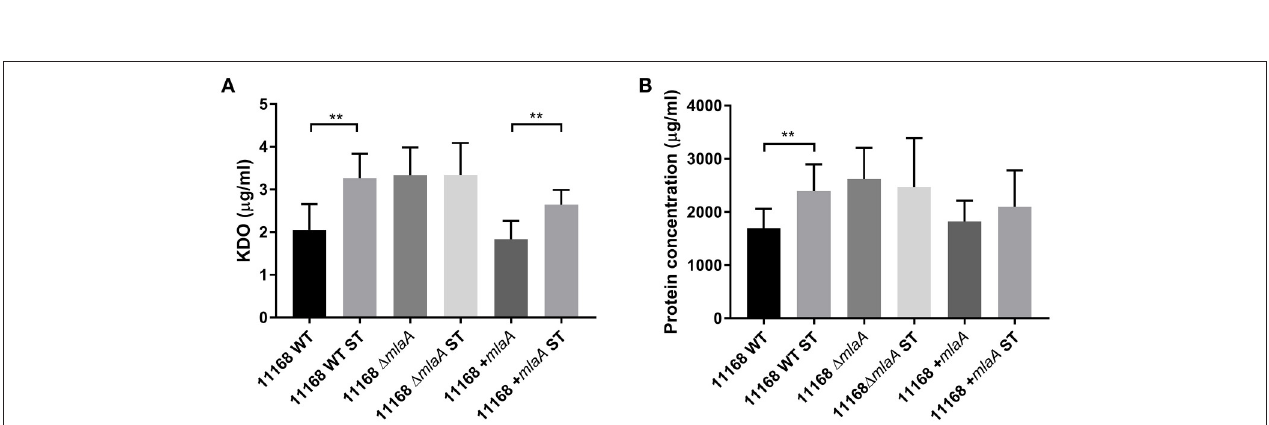
FIGURE 5 | The presence of a biologically relevant concentration of ST increases OMV production in C. jejuni wild-type strain but not in the mlaA mutant. OMVs were isolated from late-log phase C. jejuni cultures grown in Brucella broth either in the presence or absence of 0.2% (w/v) ST. OMV and ST-OMV preparations from cultures of C. jejuni wild-type, mlaA mutant and complement strains of equivalent OD 600 values were quantified by analyzing (A) total KDO as a measurement of LOS and (B) total protein ** p < 0.01.